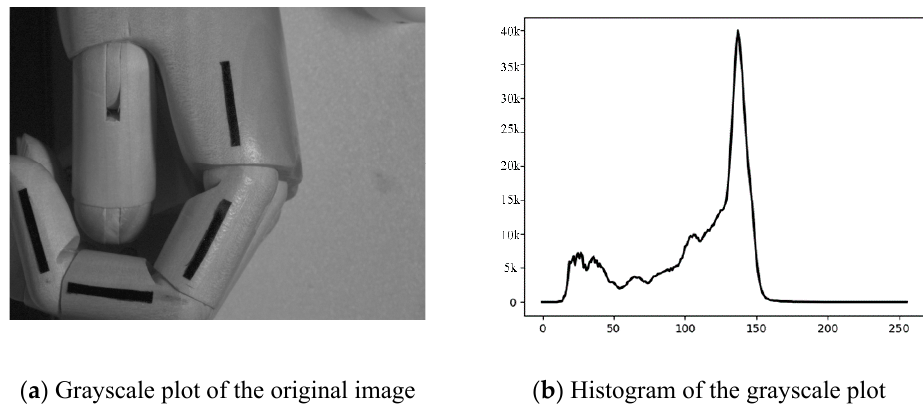
Figure 6. Grayscale conversion of the original image with the histogram.